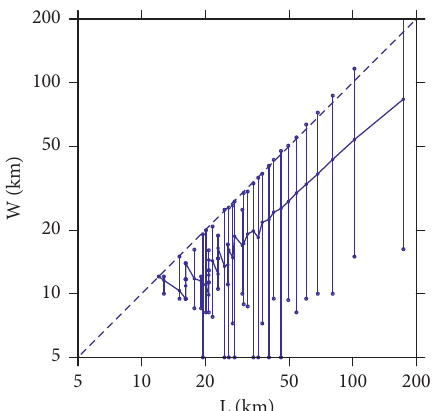
Figure 6: The relationship between W and L on Tibetan Plateau from 1998 to 2015 based on the statistical principle of same samples in each interval at x axis.